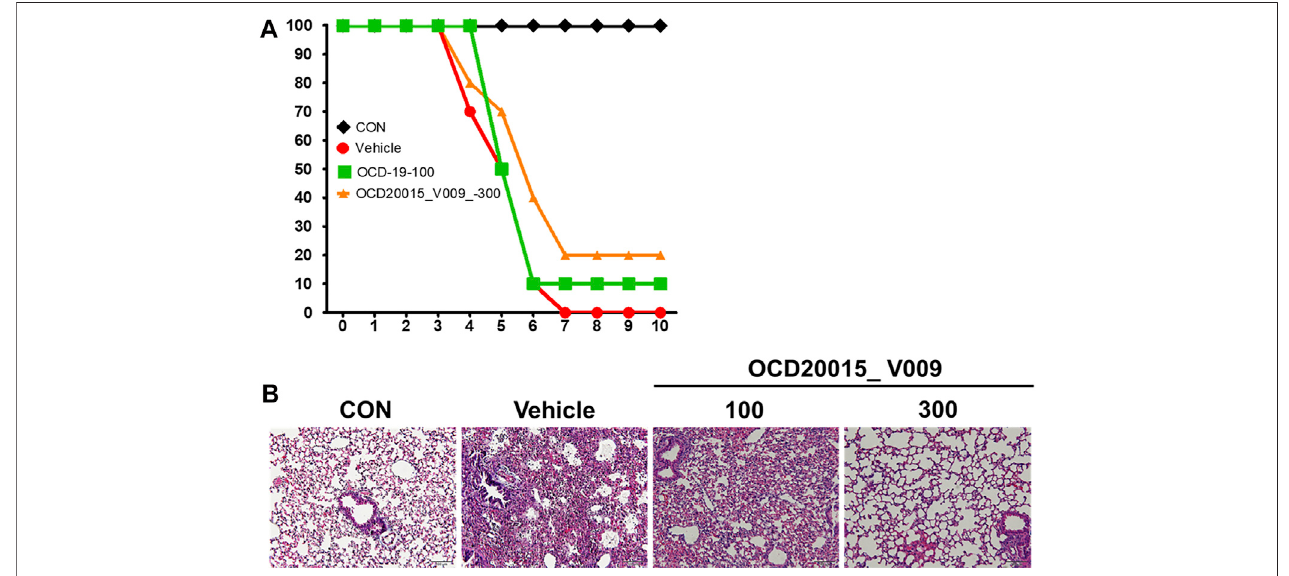
FIGURE 2 | The effect of OCD20015-V009 pre-treatment on in fl uenza A virus infection in mice. The BALB/c mice were pre-treated orally with 100 or 300 mg/kg OCD20015-V009 (200 μ L/mouse) 7 days before viral infection. (A) The daily percentage of survival until 10 days post-infection. (B) A representative H&E image of the histopathological damage in sectioned lung tissue samples from the untreated mice or mice pre-treated with OCD20015-V009.